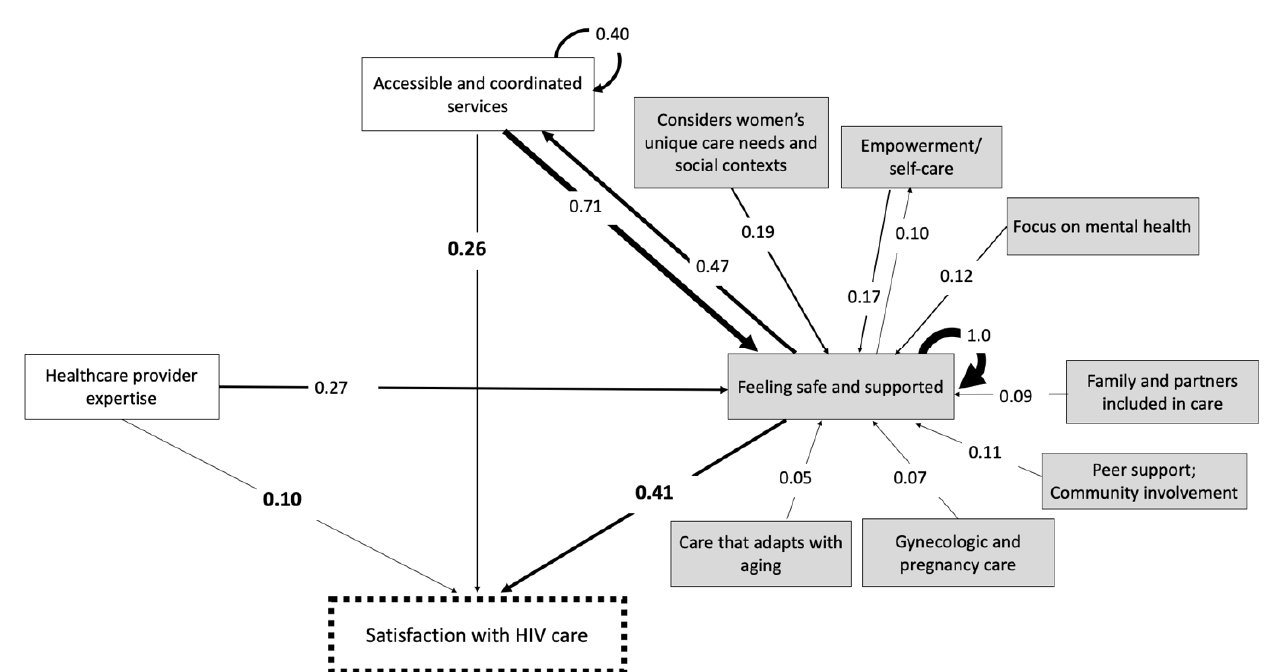
Figure 3. Summary Fuzzy Cognitive Map of category-level relationships showing the three highest weighted direct influences and the highest weighted indirect influences on satisfaction with HIV care. Weights closer 1 indicate stronger influences. The highest weighted influences on satisfaction with HIV care are bolded. Grey boxes represent new constructs added to the literature-based